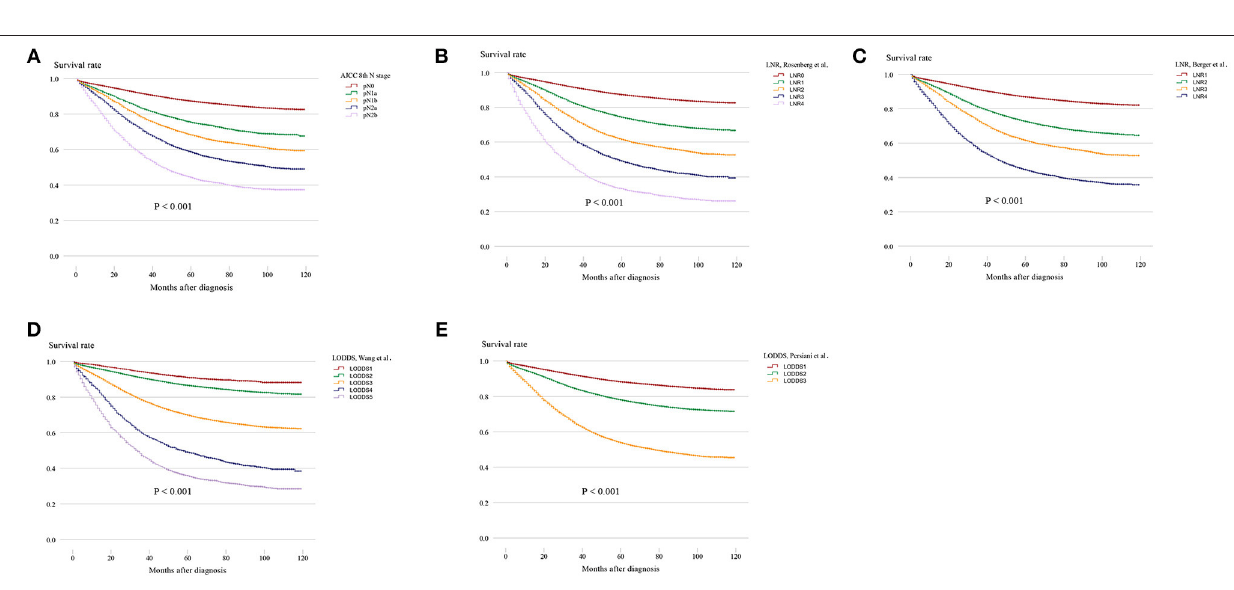
FIGURE 2 | Kaplan–Meier survival curves for five-year OS stratified by LN categories based on the (A) AJCC 8th N stage, (B) LNR of Rosenberg et al. (C) LNR of Berger et al. (D) LODDS of Wang et al. and (E) LODDS of Persiani et al. (LN, lymph node; AJCC, American Joint Committee on Cancer; LNR, lymph node ratio; LODDS, log odds of positive lymph